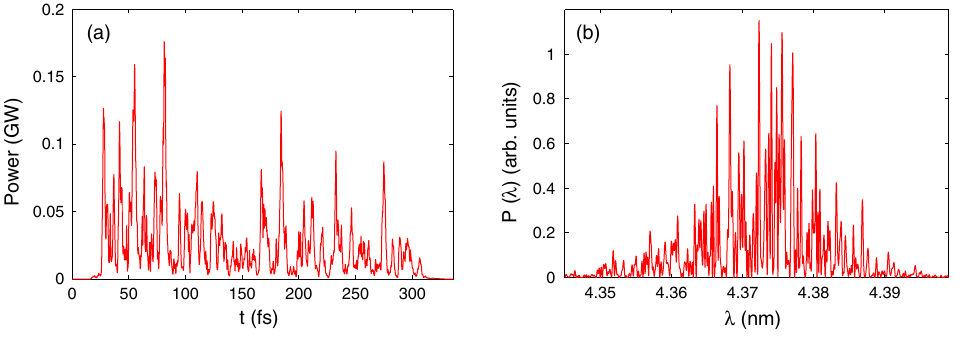
FIG. 4. FEL power (a) and spectrum (b) before the monochromator.